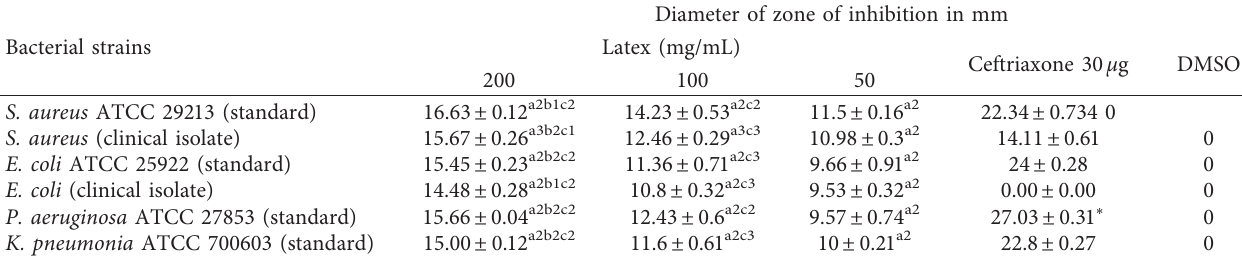
Table 1: Zone of inhibition of the leaf exudate of Aloe megalacantha against bacterial species. Bacterial